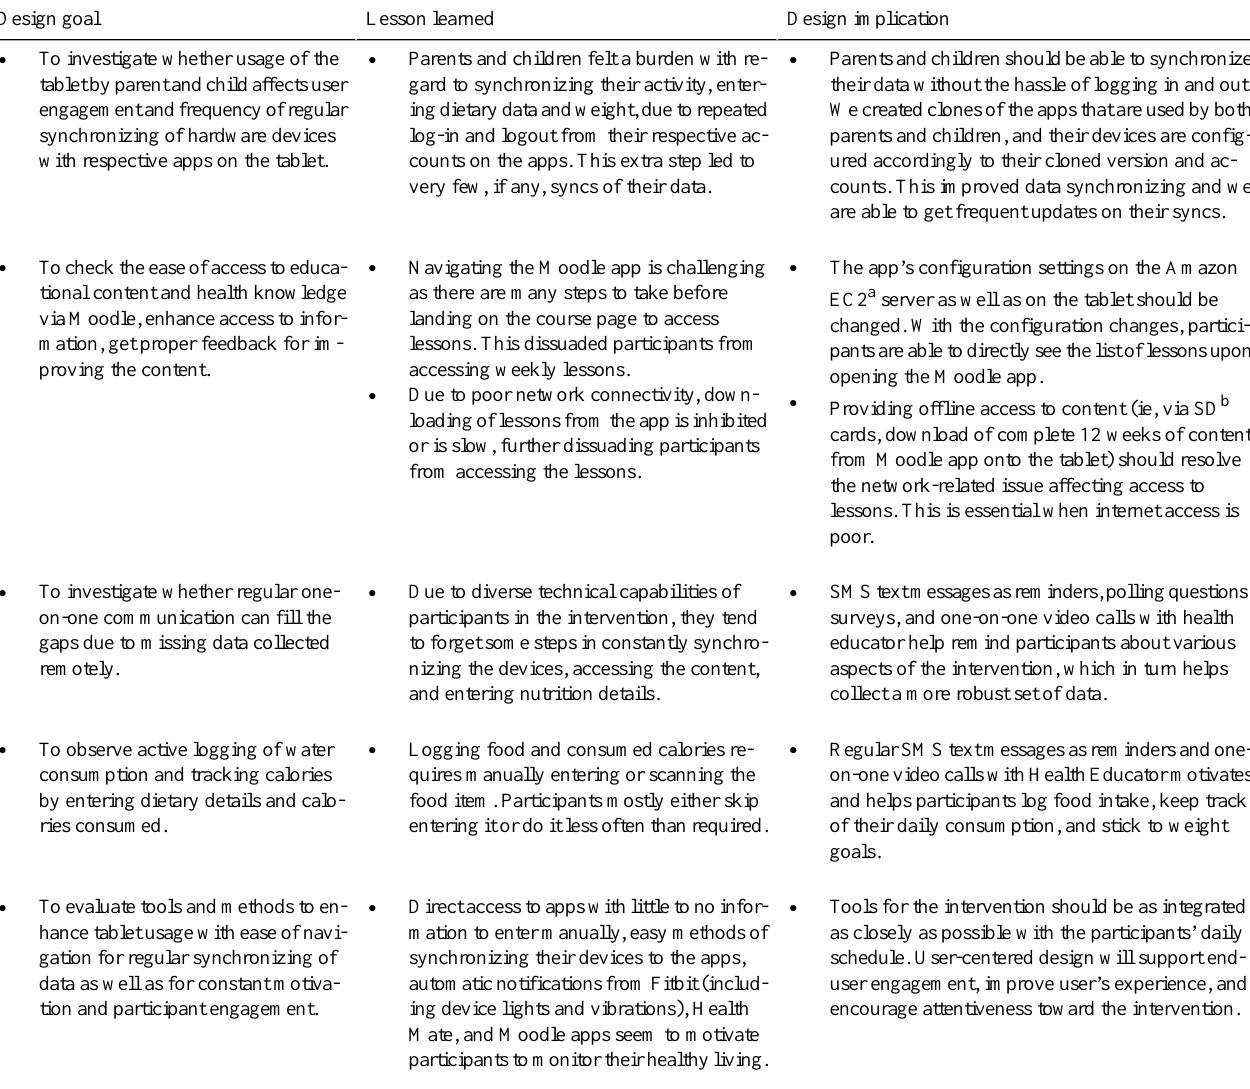
Table 4. Summary of goals, design implications, and lessons learned in the design of remote technology